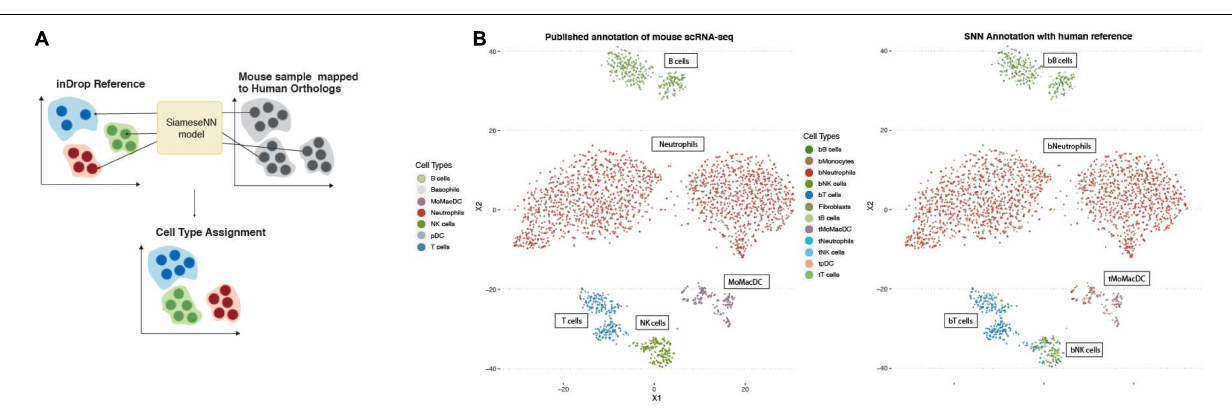
FIGURE 6 | Inter-species annotation transfer. (A) Transfer annotation from human to mouse. Mouse genes were mapped to human orthologs and MapCell prediction was performed on mouse scRNA-seq data using the NSCLC model. (B) (Left) Published annotation of mouse scRNA-seq data (Right) SNN predicted cell types using human